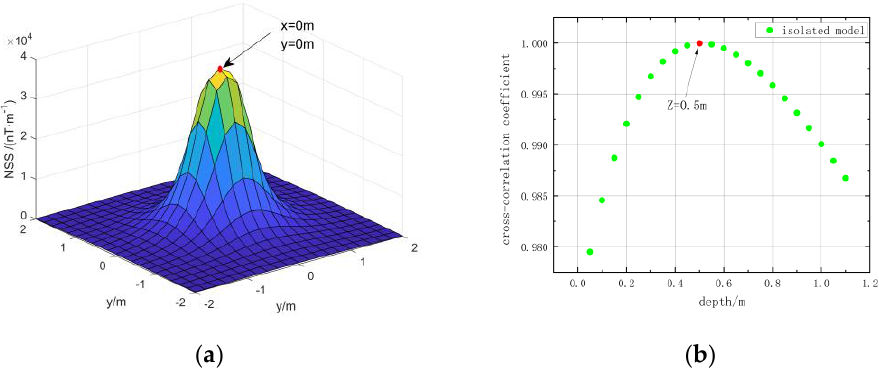
Figure 11. Estimated results of the center position of the simulation model; ( a ) Horizontal position of the model; ( b ) horizontal position of the model.